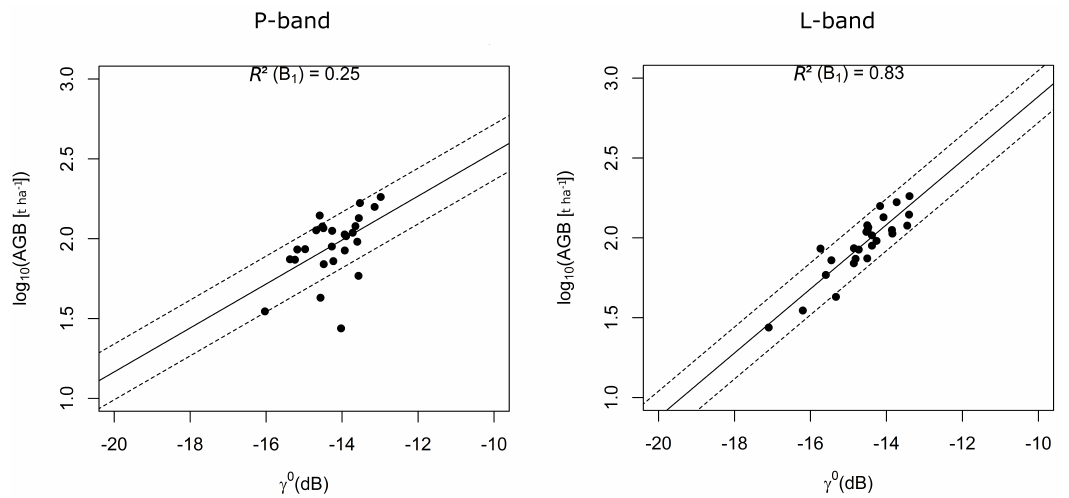
Figure 4. Log relationship between HV backscatter ( γ 0 [dB]) and aboveground biomass of forest stands for P- ( left ) and L-band ( right ) in Krycklan (dashed line is for the uncertainty of the intercept; 313 ◦ heading). The co-polarized phase difference φ HHVV was similar to Remningstorp higher at P-band compared to L-band. The phase difference at P-band ranged from − 1.1 to − 0.4 with an average of − 0.78, whereas it ranged from − 0.7 to − 0.14 with an average of − 0.38 at L-band (Figure 3). This confirmed again that double bounce scattering was larger at P-band than at